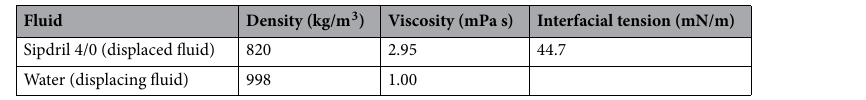
Table 1. Fluid properties at 20 ◦ C.